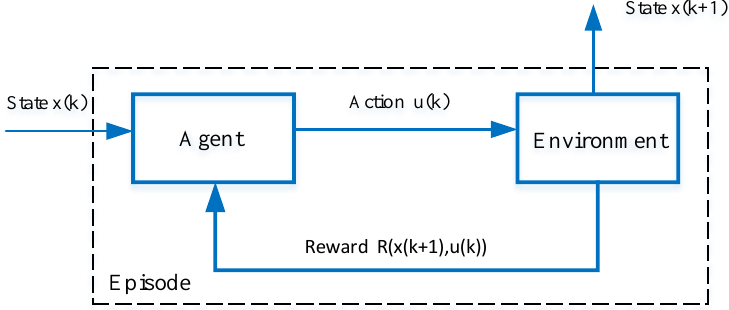
Figure 2. The basic frame of reinforcement learning.